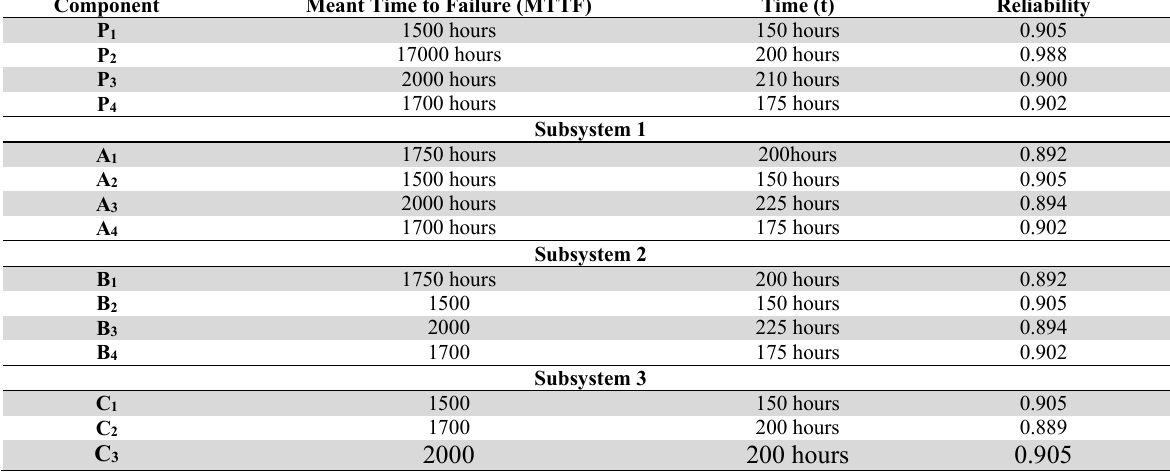
MTTF values and the calculated values of reliability for each component Component Meant Time to Failure (MTTF) Time (t) Reliability P